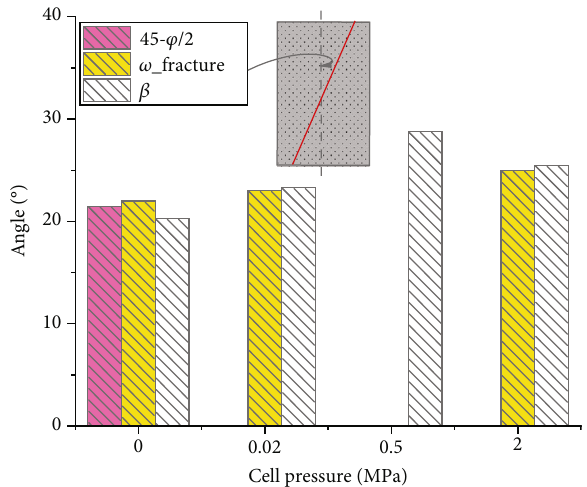
Figure 16: Comparisons between β and ω